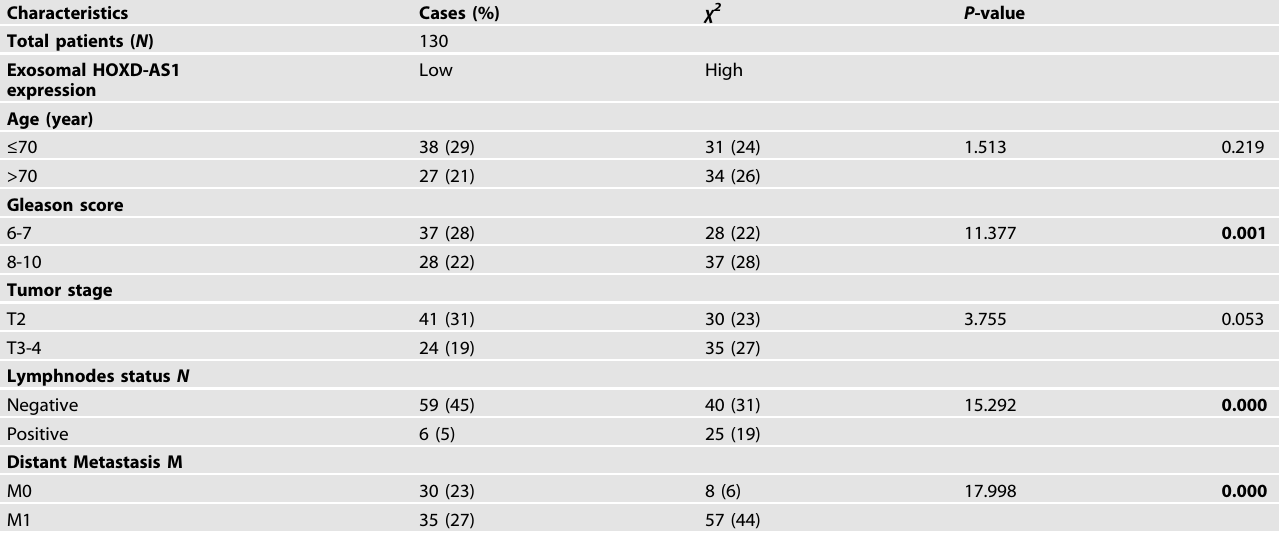
Table 1. Association between serum exosomal HOXD-AS1 expression and clinicopathological features of prostate cancer patients. Characteristics